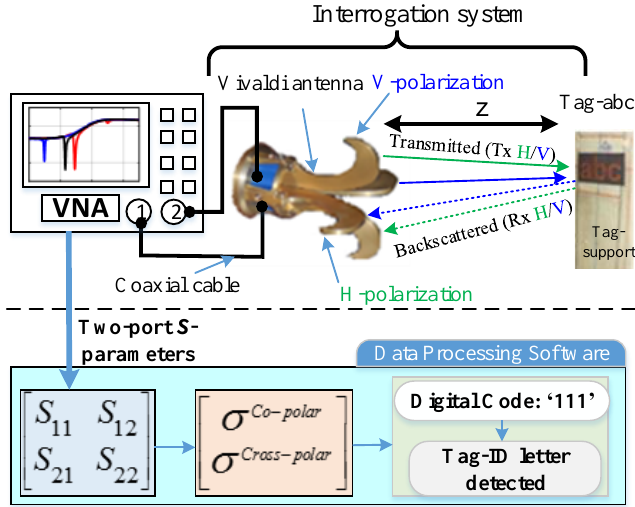
Figure 22. Strategy of measurement for the identification of chipless tags.